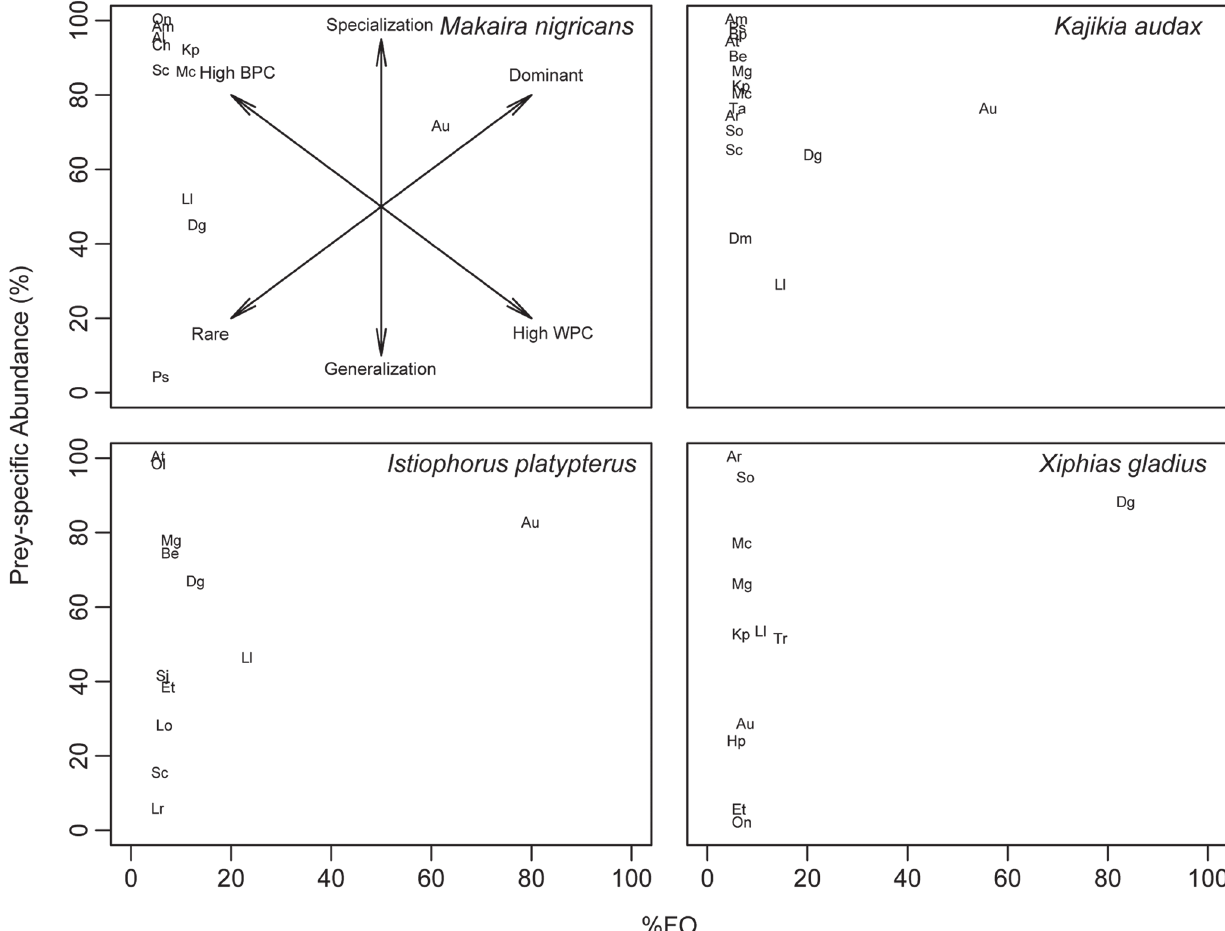
Fig. 3. Prey-specific abundance plotted against frequency of occurrence of prey species. Explanatory axes for foraging patterns are those of Costello (1990) as modified from Amundsen et al. (1996). The two diagonal axes represent the importance of prey (dominant vs. rare) and the contribution to the niche width (high between-phenotype vs. high within-phenotype contribution); the vertical axis defines the predator feeding strategy (specialist vs. generalist). Al, Ancistrocheirus lesueurii ; Am, Aluterus monoceros ; Ar, Argonauta spp.; At, Auxis thazard ; Au, Auxis spp.; Be, Belonidae; Bp, Balistes polylepis ; Ch, Coryphaena hippurus ; Dg, Dosidicus gigas ; Dm, Decapterus macrosoma ; Et, Etrumeus teres ; Hp, Hyaloteuthis pelagica